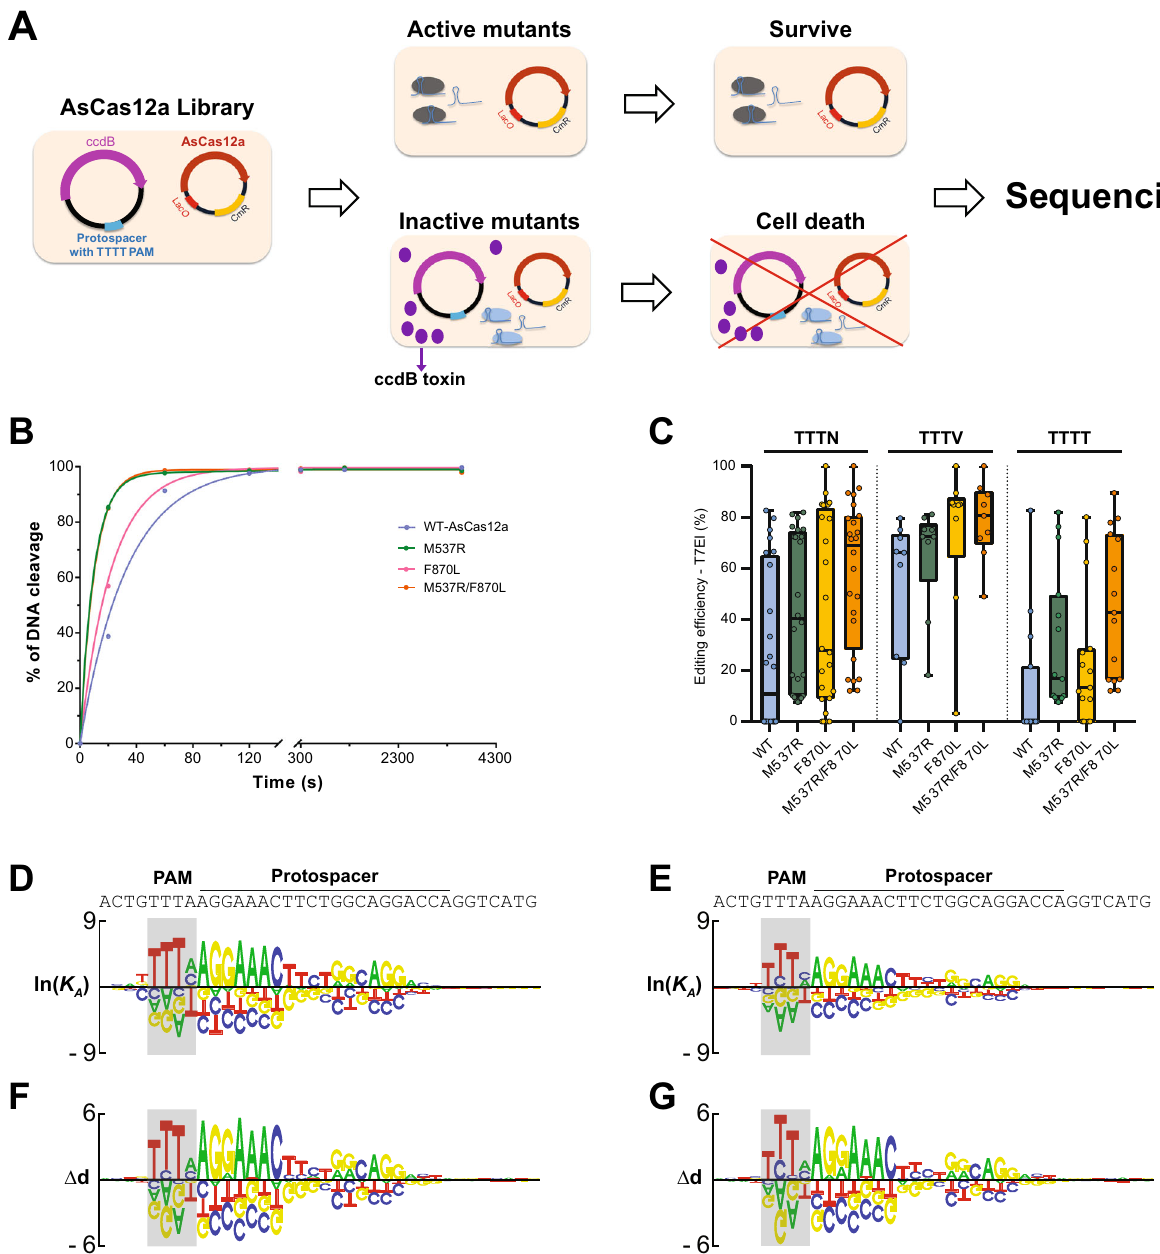
Fig. 1 Directed evolution of AsCas12a with enhanced activity. A Schematic representation of a bacterial-based variant selection of AsCas12a. E. coli cells harboring an inducible toxin-expression reporter were transformed with plasmids encoding AsCas12a with random mutations, which is programmed to target a de fi ned protospacer with TTTT PAM on the reporter. Active AsCas12a variants that can cleave the reporter plasmid enabled cell survival upon arabinose induction. The frequency of AsCas12a variants over multiple rounds of selection was determined by sequencing. B The in vitro DNA cleavage activities of WT-AsCas12a, M537R, F870L, and M537R/F870L (AsCas12a Ultra) at a protospacer with TTTT PAM. Pre-assembled AsCas12a RNP (125 nM) was incubated with dsDNA substrate (10 nM). The substrate cleavage percentage at various time points was measured by capillary electrophoresis. C Genome editing ef fi ciency of WT, M537R, F870L, and M537R/F870L (AsCas12a Ultra) in HEK293 cells as RNP (5 μ M) over 24 sites targeting CTNNB1 gene ( n = 24). D , E The in vitro DNA binding speci fi city of WT and AsCas12a Ultra measured by Spec-seq . F , G The in vitro DNA cleavage speci fi city of WT and AsCas12a Ultra measured by SEAM-seq . Raw source data are provided in the Source Data